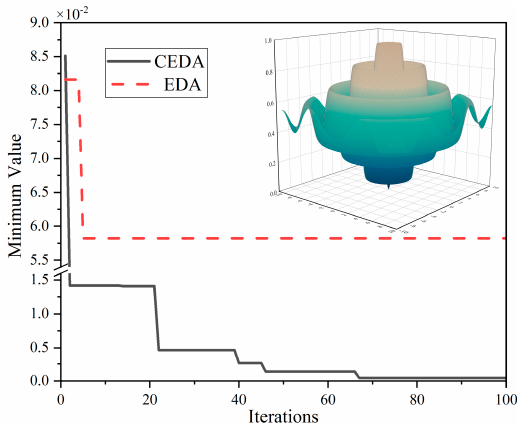
Figure 8. The result of test function extremum finding by CEDA and EDA.